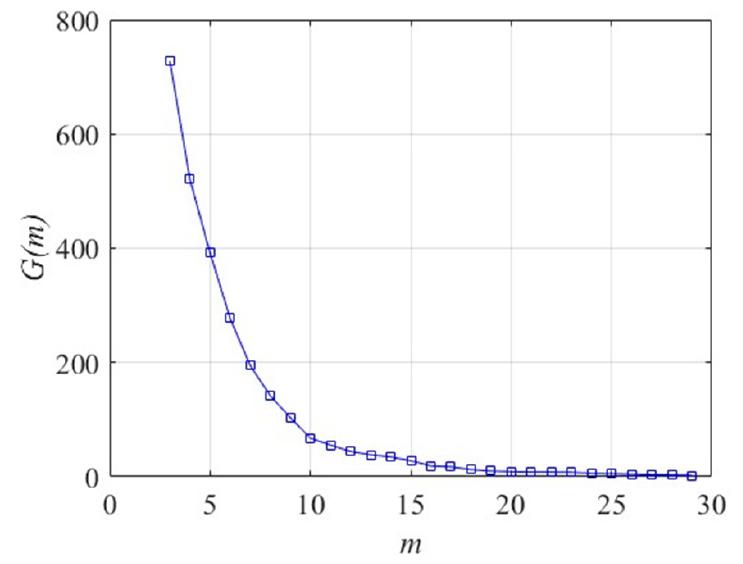
Figure 17. Determination of the delay time.